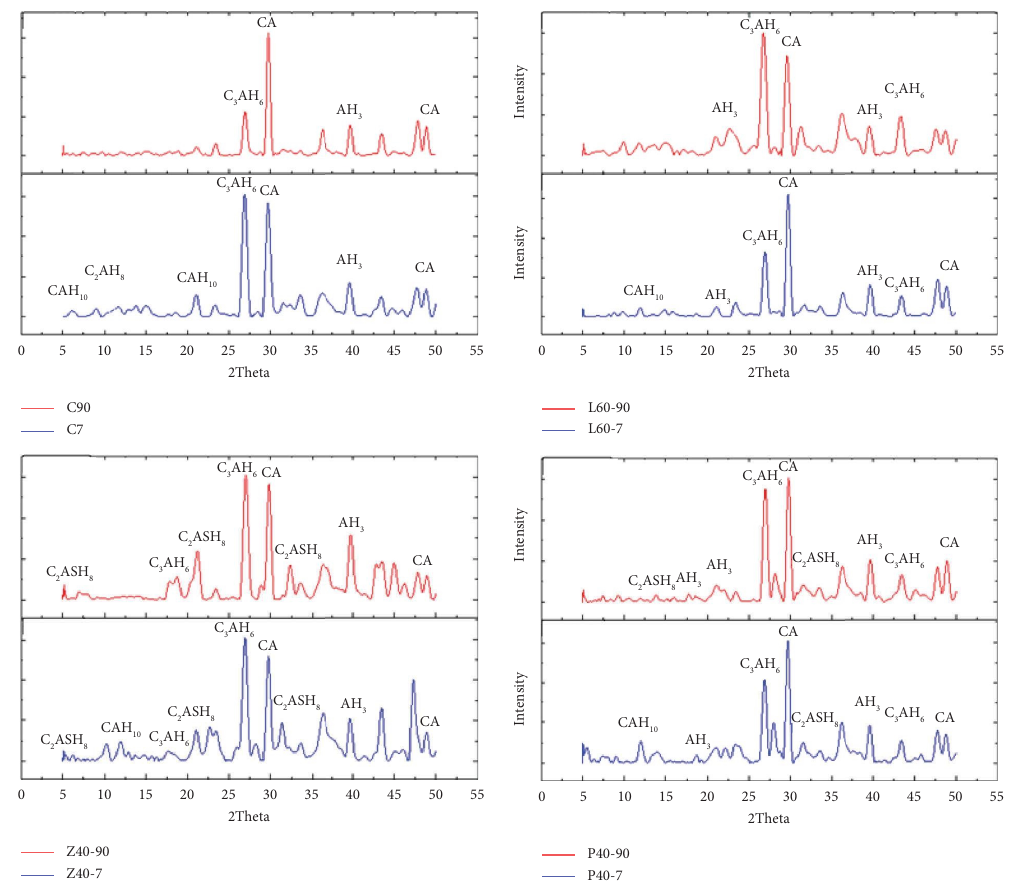
Figure 1: Te X-ray difraction patterns for the plain mixture and the mixtures containing 40% SCMs after 7 and 90days of hydration.